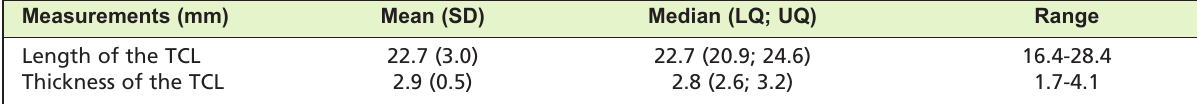
Length and thickness of the transverse carpal ligament (TCL) Table III: